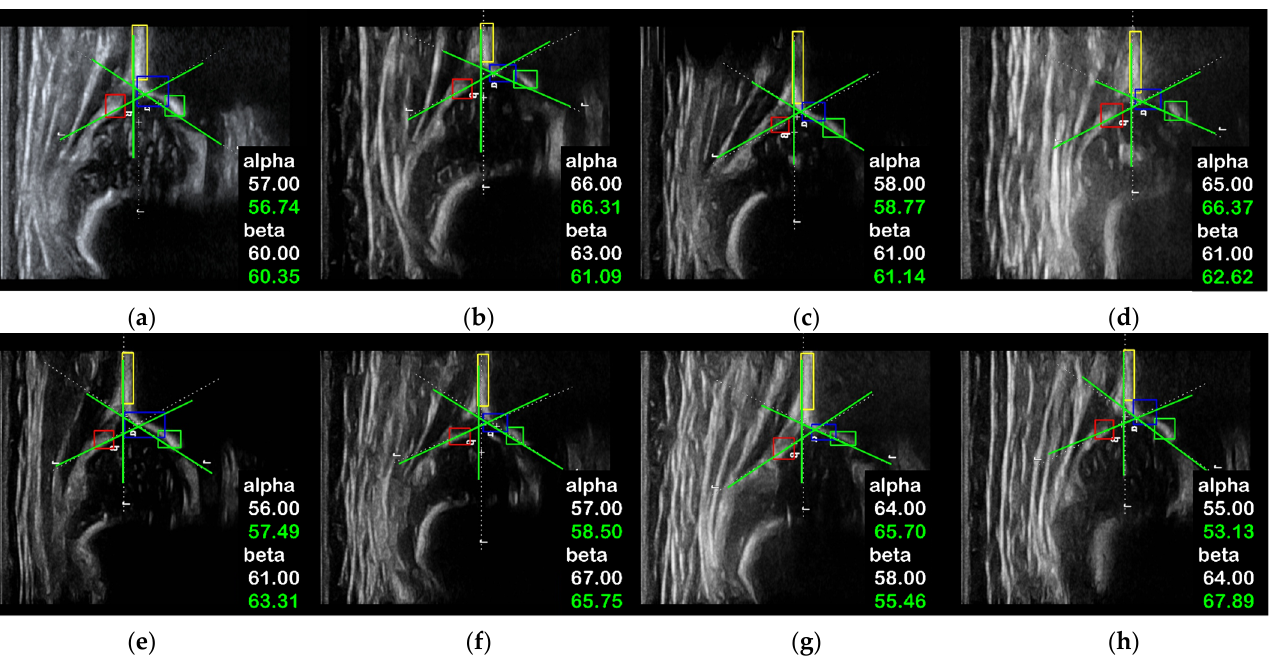
Figure 7. Qualitative comparisons for the angle measurement between the SM mode and the sonographers. The white dash lines are the manual plot in clinic. The green lines are formed by the SM mode based on the detected bounding boxes. The white values are given by sonographers, and the green values are given by the SM mode. The absolute differences between SM mode and sonographers are ( a ) Δα = 0.26°, Δβ = 0.35°; ( b ) Δα = 0.31°, Δβ = 1.91°; ( c ) Δα = 0.77°, Δβ = 0.14°; ( d ) Δα = 1.37°, Δβ = 1.62°; ( e ) Δα = 1.49°, Δβ = 3.31°; ( f ) Δα = 1.50°, Δβ = 1.25°; ( g ) Δα = 1.70°, Δβ = 2.54°; ( h ) Δα = 1.87°, Δβ = 3.89°.